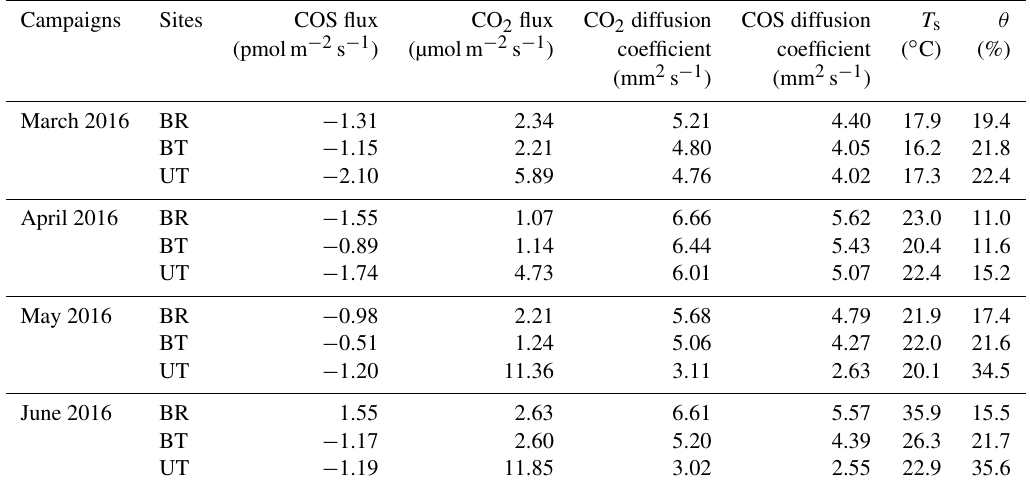
Table 2. Estimates of soil COS and CO 2 fluxes from soil concentration gradient measurements ( T s , soil temperature; θ , soil water content; BR, between rows; BT, between trees; UT, under tree). Campaigns Sites COS flux CO 2 flux CO 2 diffusion COS diffusion T s θ (pmolm − 2 s − 1 ) (µmolm − 2 s − 1 ) coefficient coefficient ( ◦ C) (%) (mm 2 s − 1